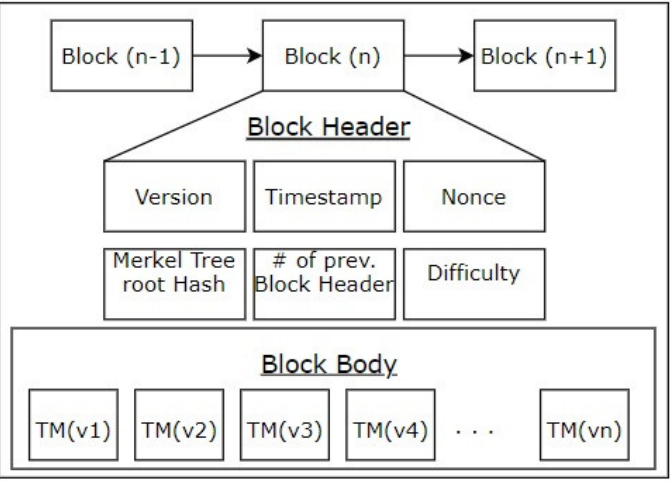
Figure 2. The structure of the